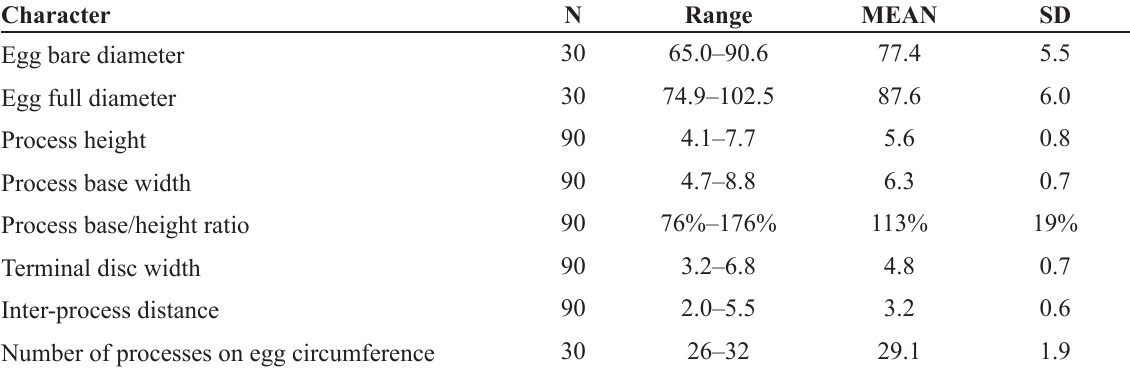
Table 5. Measurements (in μm) of selected morphological structures of the eggs of Macrobiotus kamilae sp. nov. mounted in Hoyer’s medium (N = number of eggs/structures measured; Range = the smallest and the largest structure among all measured specimens; SD = standard